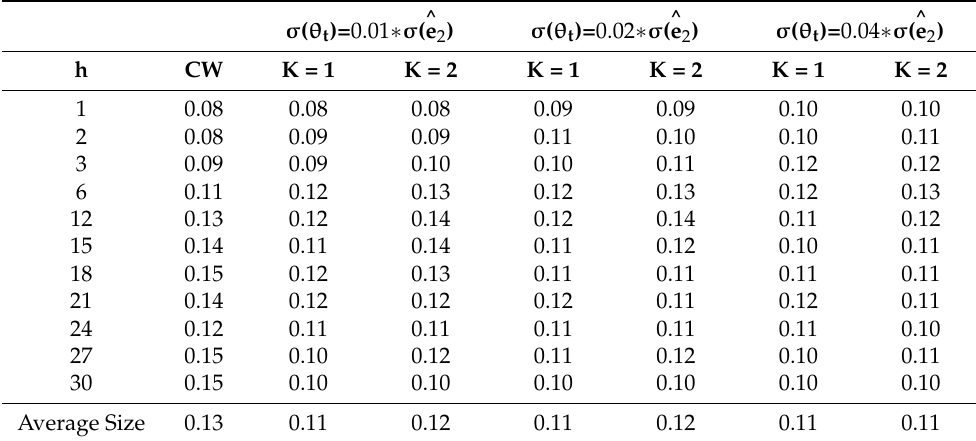
Table 5. Empirical size comparisons between CW and WCW tests with nominal size of 10%, consid- ering DGP3 and a large sample.